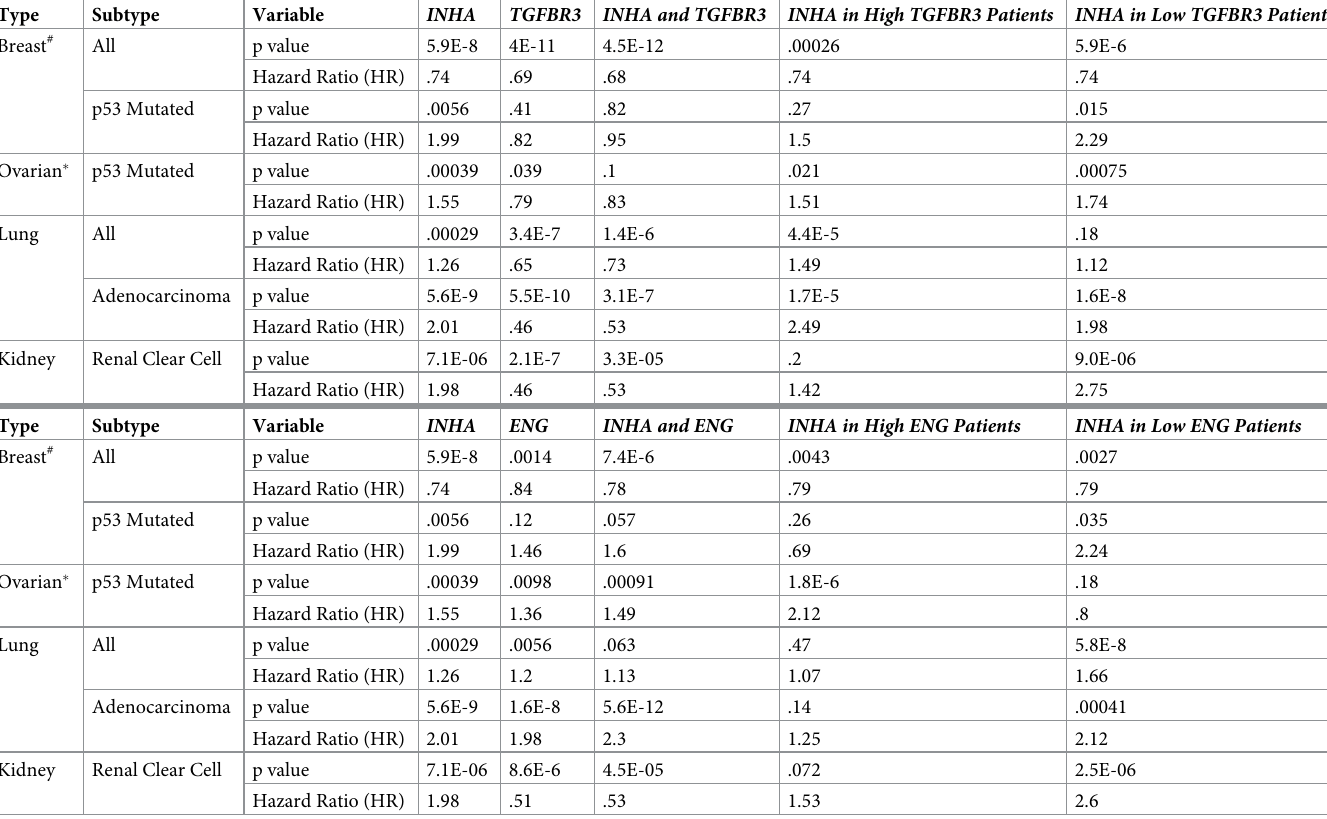
Table 1. p values and Hazard Ratios (HR) from survival curves assessing the relationship between TGFBR3/ENG and INHA on patient survival.